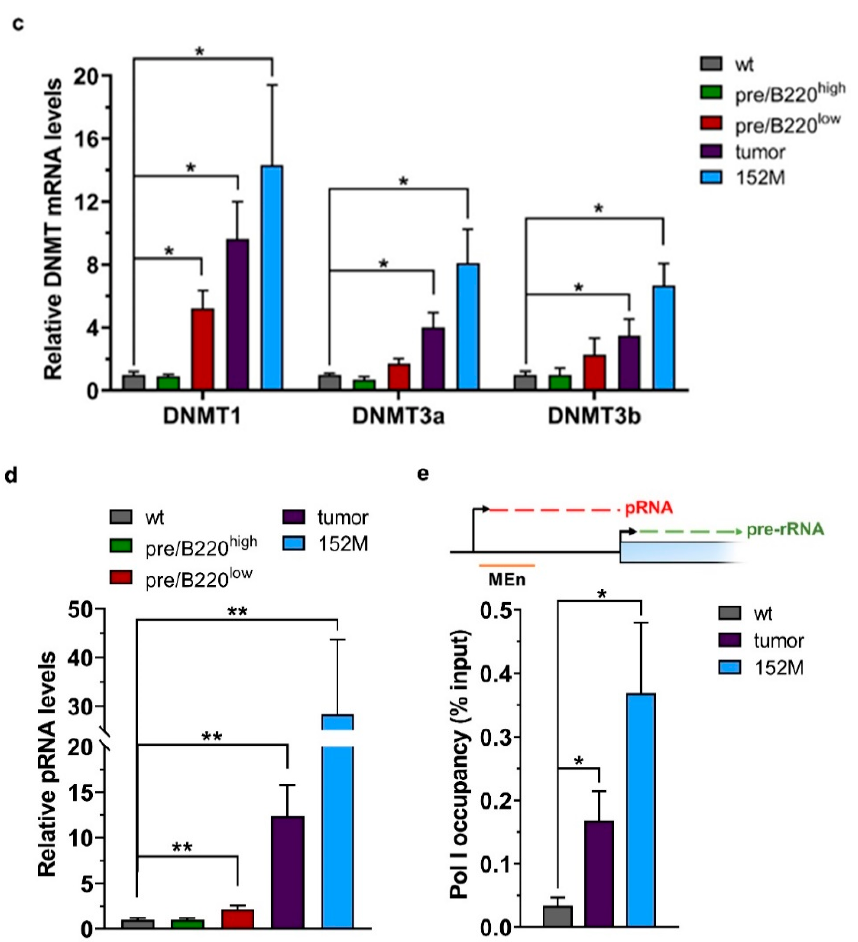
Figure 2. Epigenetic silencing of rDNA upon malignant transformation of B cells. ( a ) Scheme illustrating quantification of rDNA promoter methylation. After DNA digestion with Hpa II, qPCR for amplicons L and S provides the fraction of methylated promoters. ( b ) Ratio of promoter methylation in wt and E µ - Myc B cells. ( c , d ) Levels of DNMT1, 3a and 3b mRNAs, and of pRNA, relative to B2M mRNA in the indicated B cell populations. ( e ) RPA116 occupancy at the rDNA enhancer region upstream of